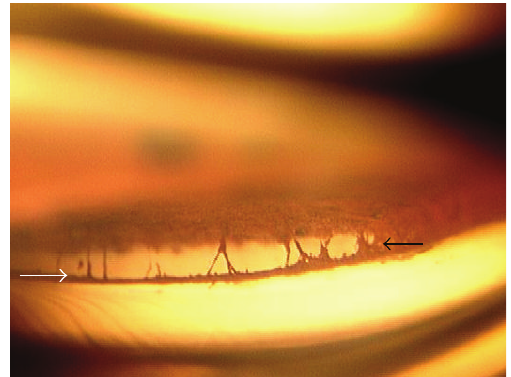
Figure 2: Gonioscopic photograph of eye showing anteriorly displaced Schwalbe line (white arrow) and irido-corneal adhesions (black